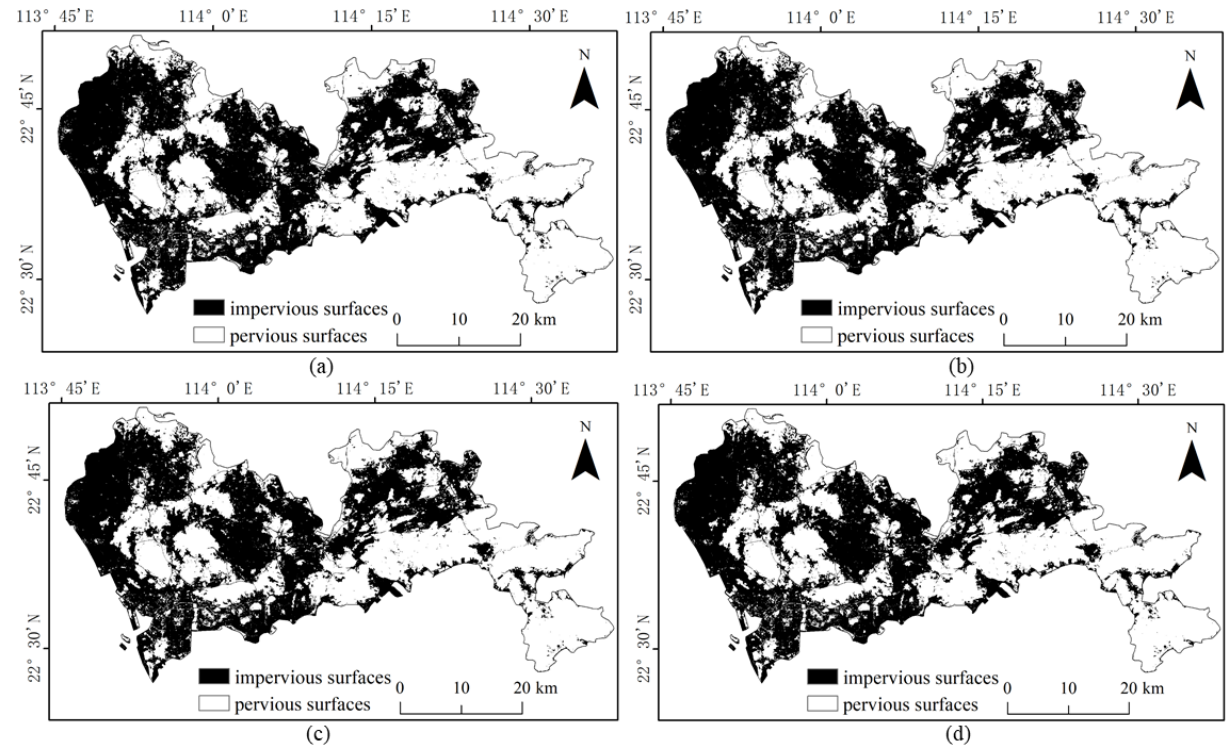
Figure 9. Results of impervious surface extraction with SVM: ( a ) 80,000 samples; ( b ) 120,000 sam- ples; ( c ) 160,000 samples; ( d ) 200,000 samples.